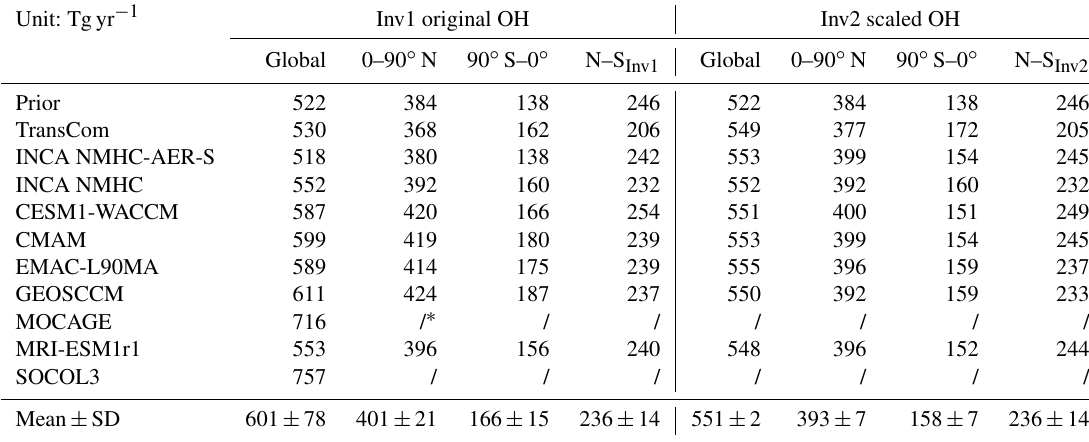
Table 2. The global total, hemispheric CH 4 emissions, and interhemispheric difference of CH 4 emissions calculated by Inv1 and Inv2 during the early 2000s (July 2000–June 2002; Tgyr − 1 ). Unit: Tgyr −